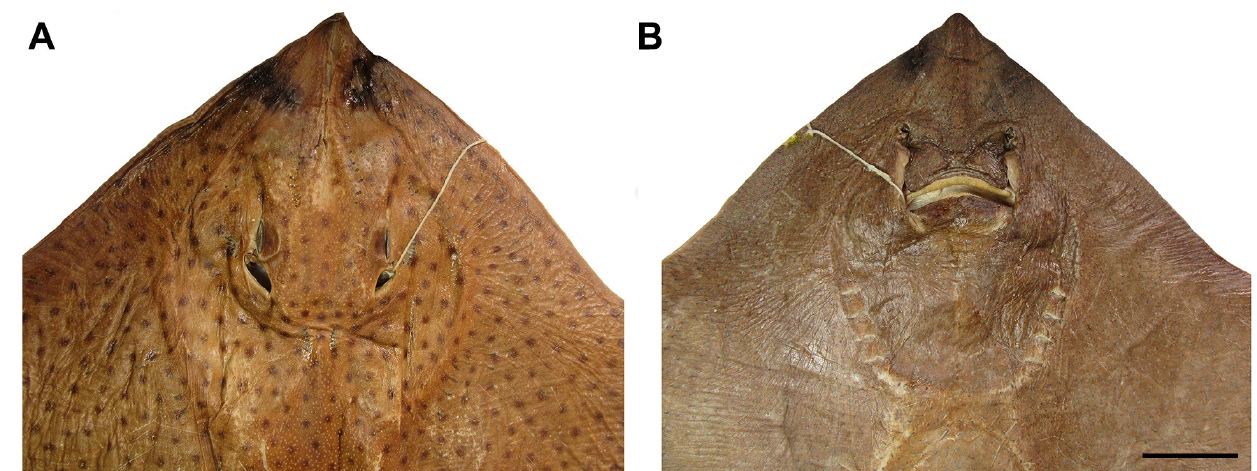
FIGURE 2 | Head region of Atlantoraja castelnaui , UERJ 1853, male, 593 mm TL. A. Dorsal view. B. Ventral view. Scale bar = 10